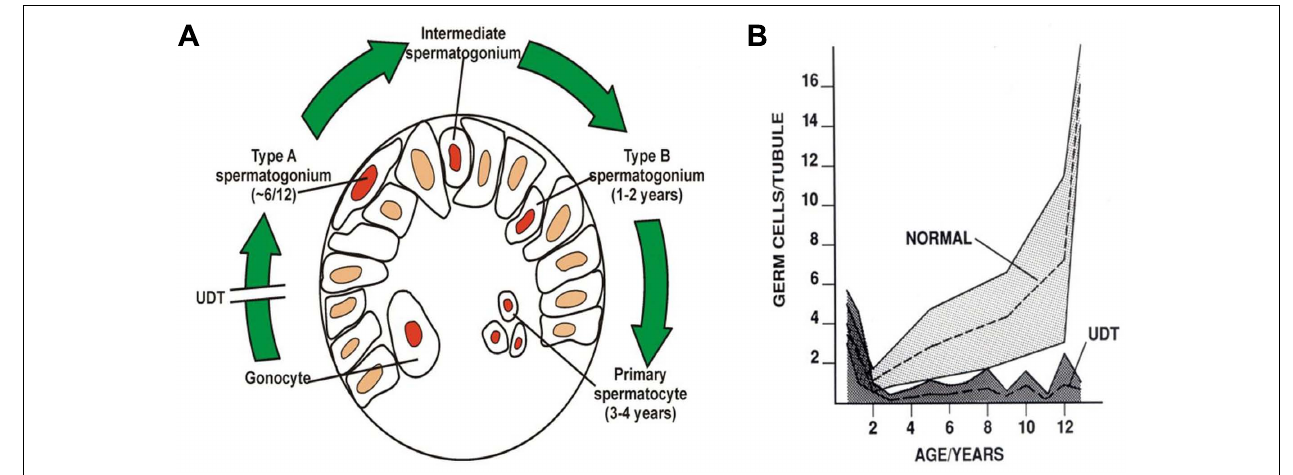
FIGURE 4 | Postnatal germ cell development in humans. (A) Gonocytes migrate from the center of the cords to the basement membrane around 6 months, and become type-A spermatogonia. By 3–4 years of age the center of the cords becomes recolonized with primary spermatocytes. (B) Numbers